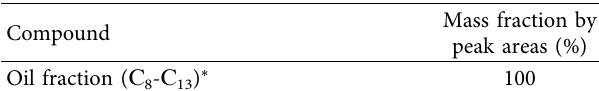
Table 2: Results of identifcation of the sample of lead sludge by